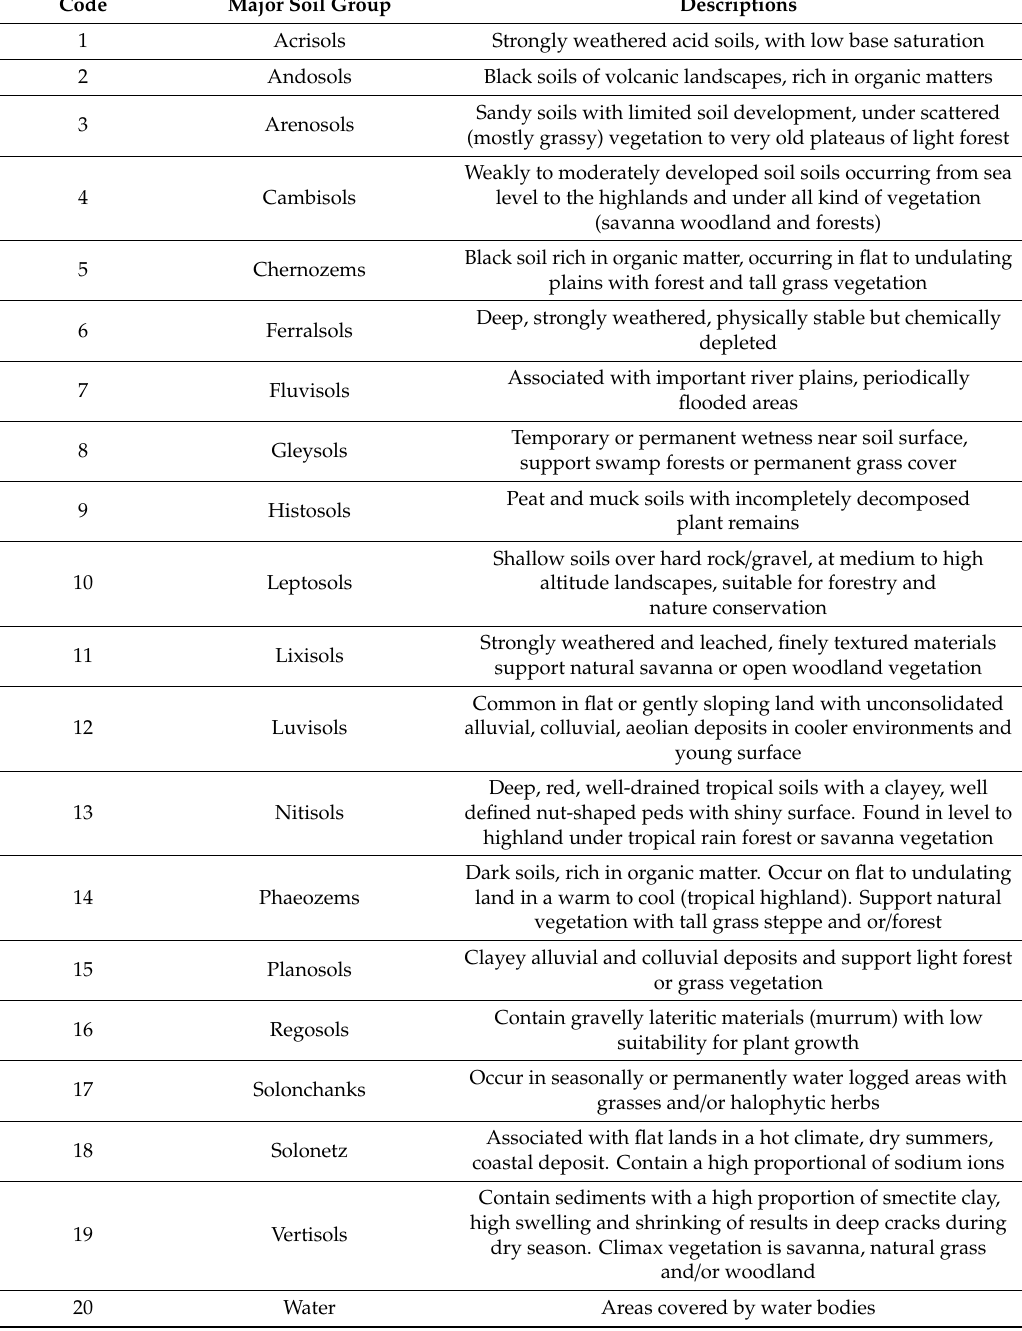
Table 1. Summary of dominant tropical soil groups for Southern Africa (Batjes,